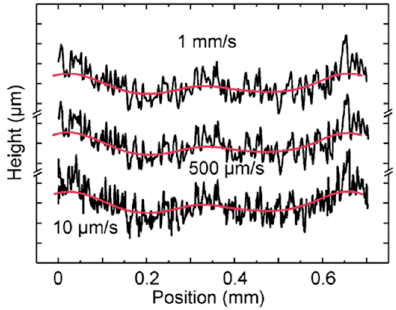
Figure 41. Roughness measurements inside a micro sac nozzle at three different traverse speeds.